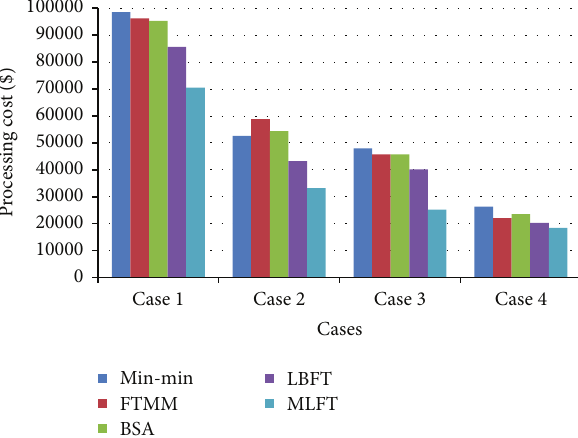
Figure 4: Performance based on makespan (sec).